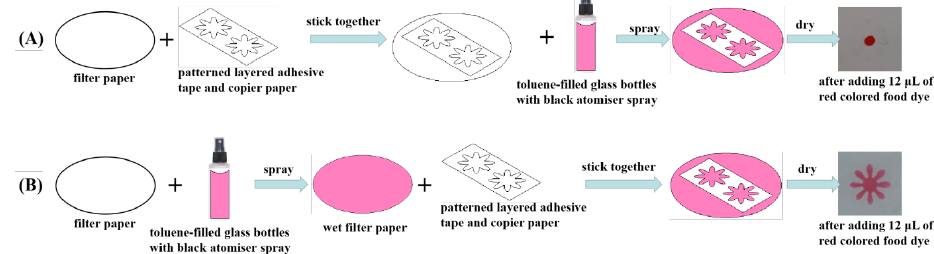
Figure 2. The optimization of the order in which toluene was sprayed. ( A ) The step of sticking together was put in the first order. ( B ) The step pf spraying toluene was put in the first